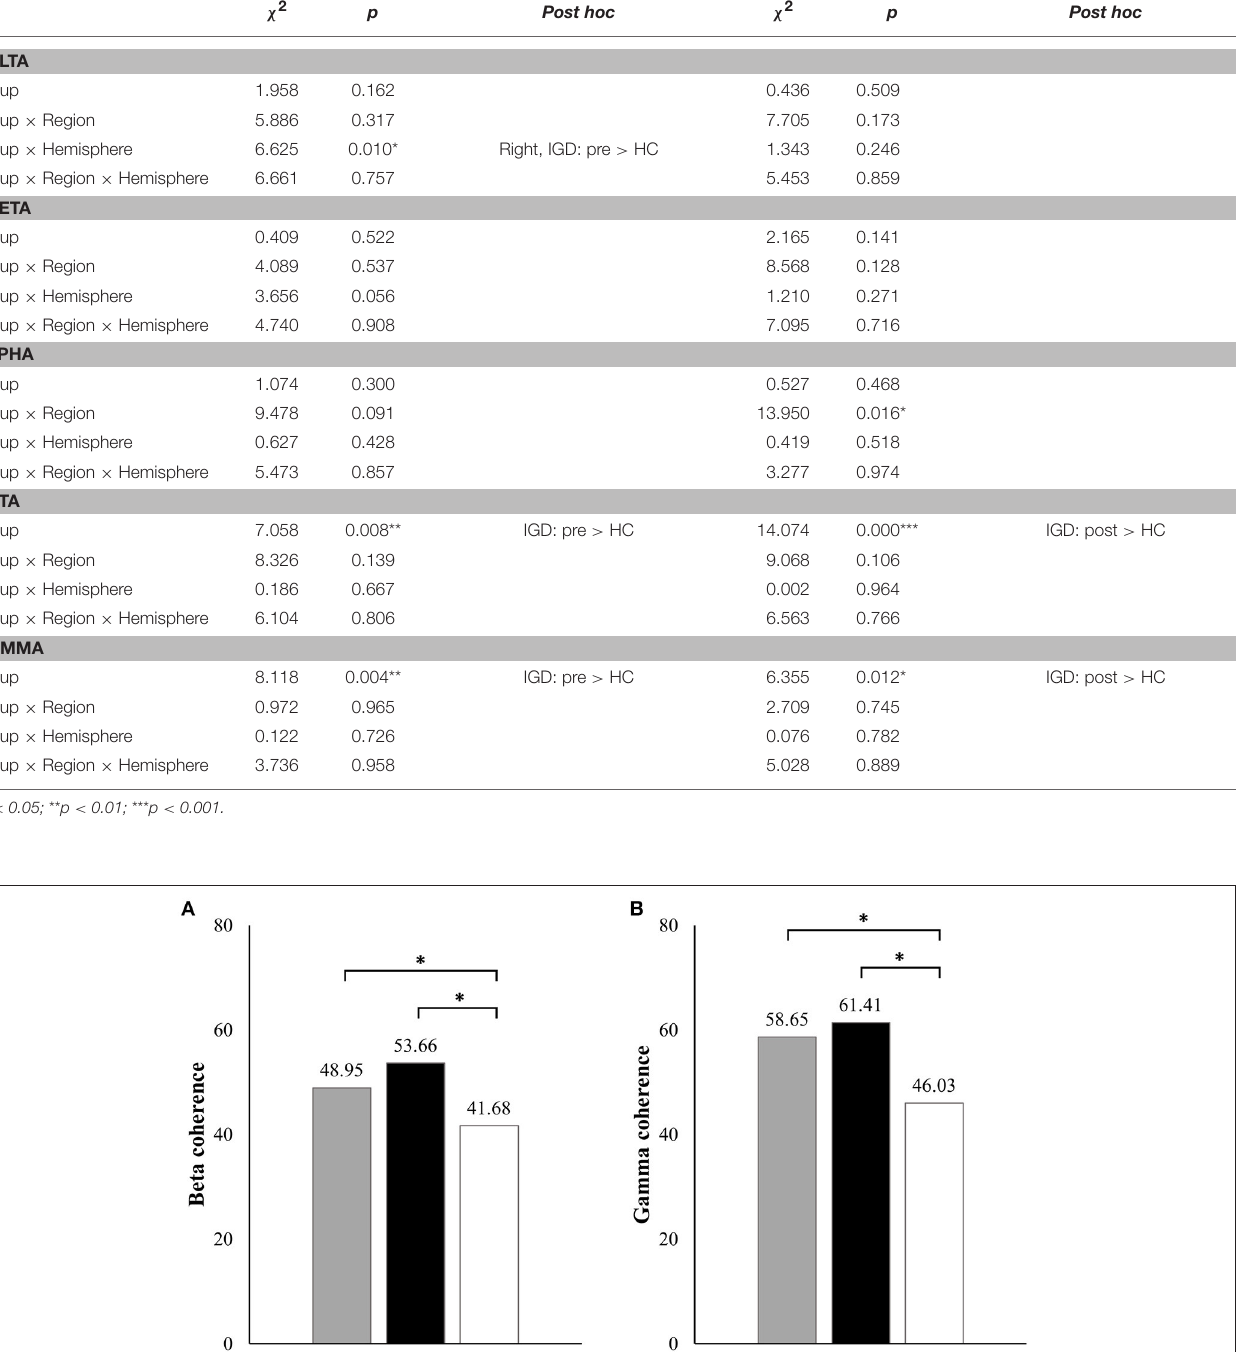
Frontiers in Psychiatry |